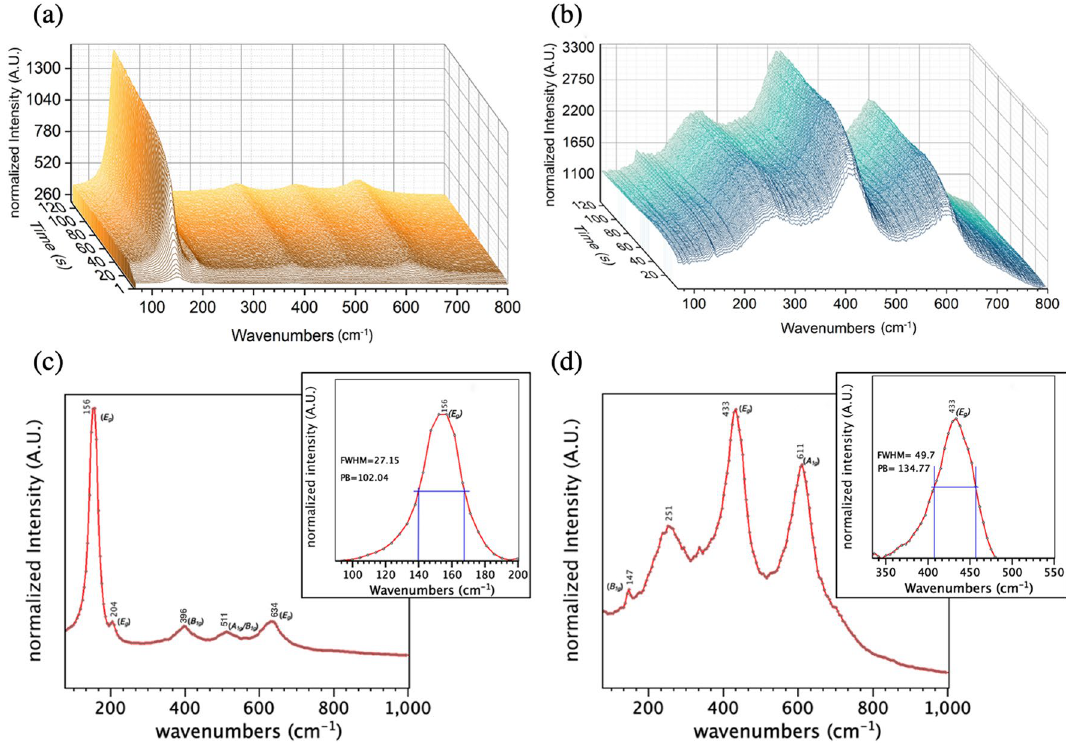
Figure 3. Transient Raman micro-spectroscopy measurements monitoring the laser-assisted conversion of the red amorphous TiO 2 . ( a ) Exposed to a 75 W/mm 2 power density. ( b ) Exposed to a 445 W/mm 2 power density. ( c ) Anatase and ( d ) rutile Raman spectra obtained using laser-assisted crystallization in ambient room environment. The insets show the E g mode broadening for each obtained